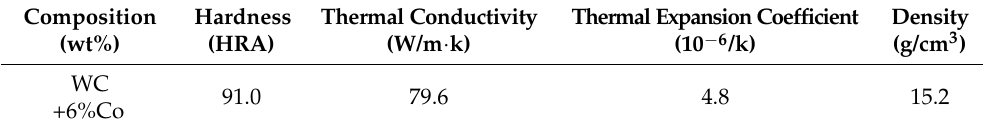
Table 1. Properties of the WC/Co cemented